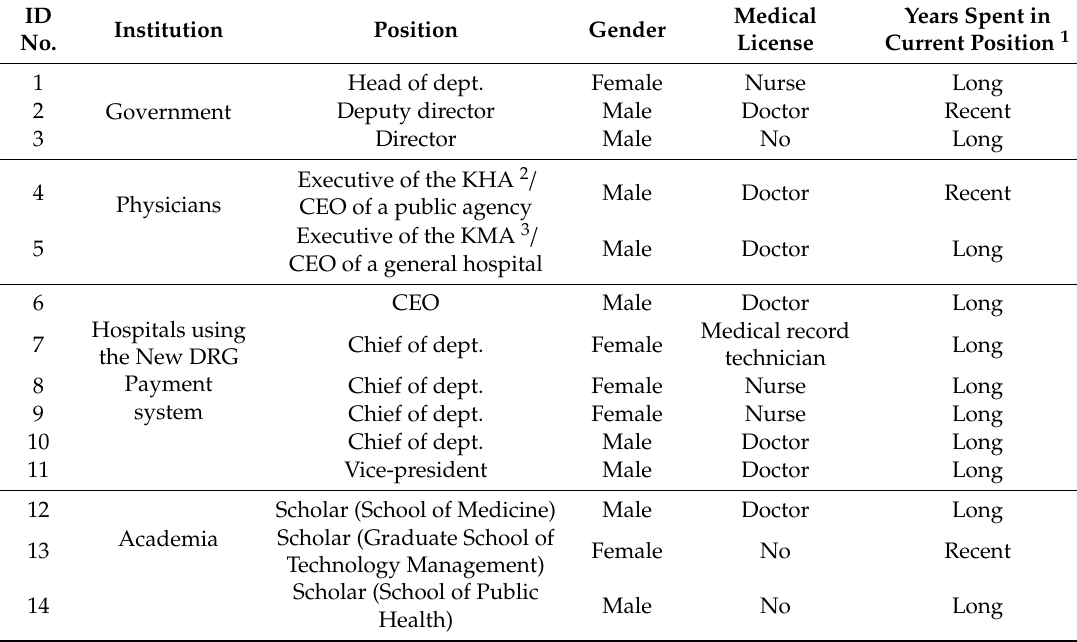
Table 1. General characteristics of